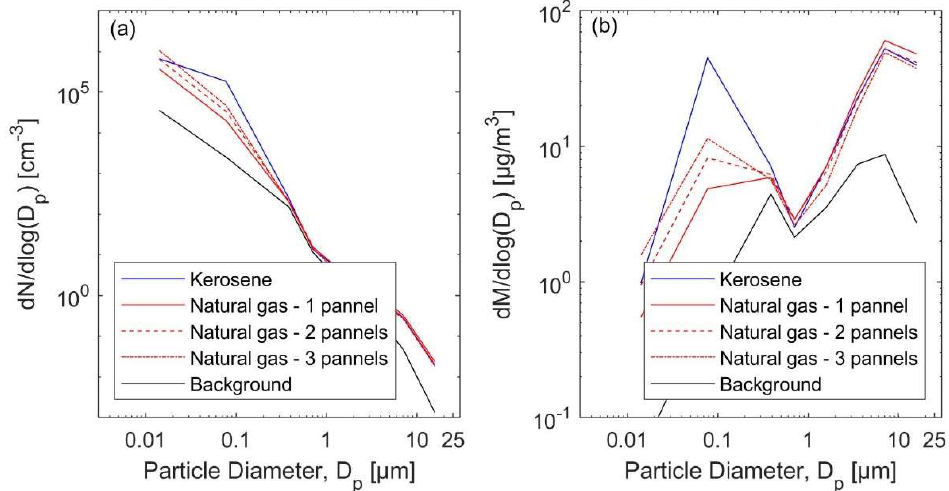
Figure 4. ( a ) Overall mean particle number size distributions observed during the operation of the heaters, compared with the background size distributions, and ( b ) corresponding particle mass size distributions.